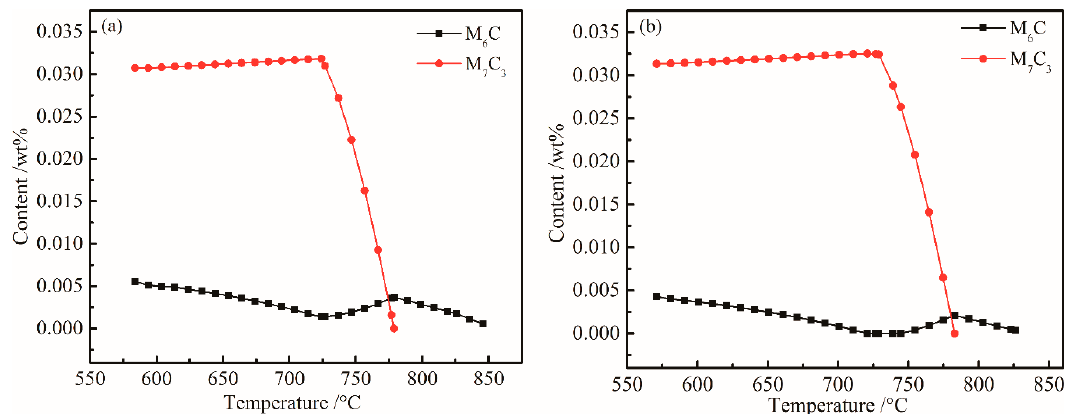
Figure 6. Plot of M 23 C 6 content (wt%) versus temperature.